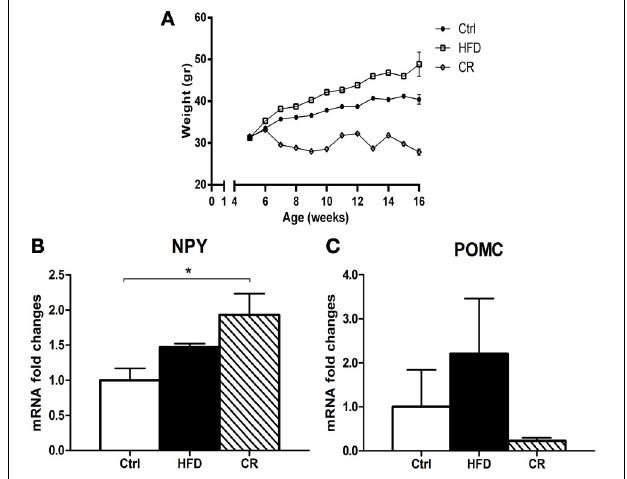
FIGURE 1 | (A) trends of the body weight of mice fed an HFD diet, a low-fat diet (Ctrl), or a CR regimen for 12 weeks. RT-PCR analysis of NPY (B) and POMC (C) expression in the hypothalamus of HFD, control (Ctrl) and CR mice. Mean ± SEM. ∗ P < 0 . 05.